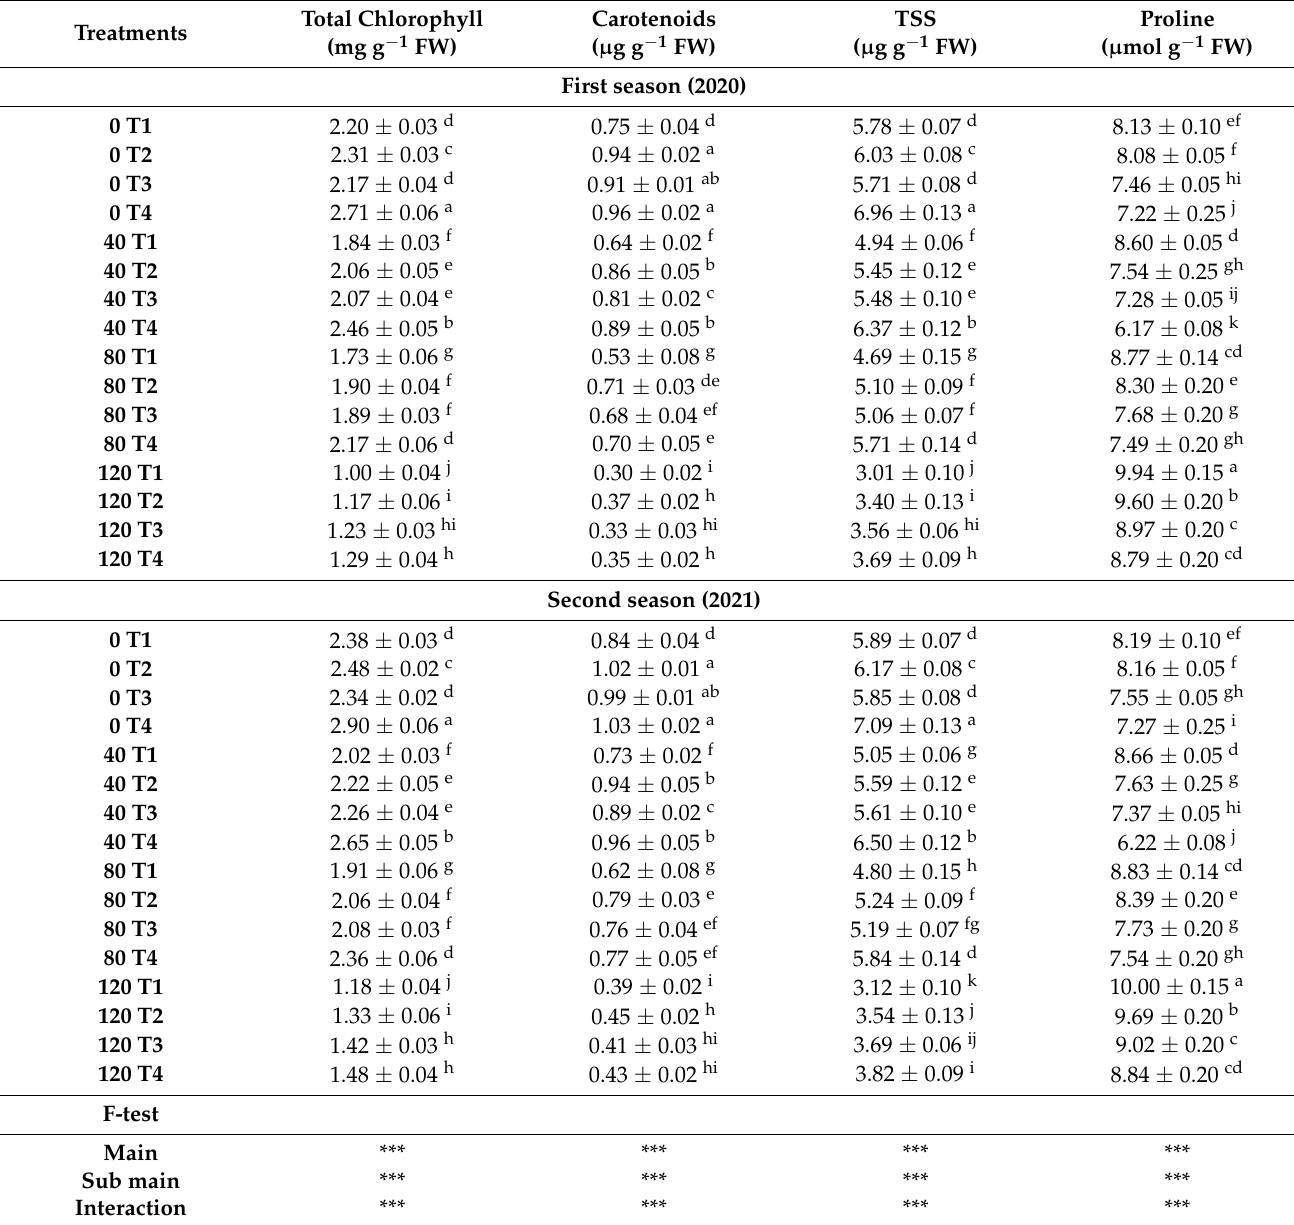
Table 2. Combined effects of different concentrations of Cd and soil amendments on total chlorophyll, carotenoids, TSS, and proline contents in lettuce leaves 30 days after transplanting during the 2020 and 2021